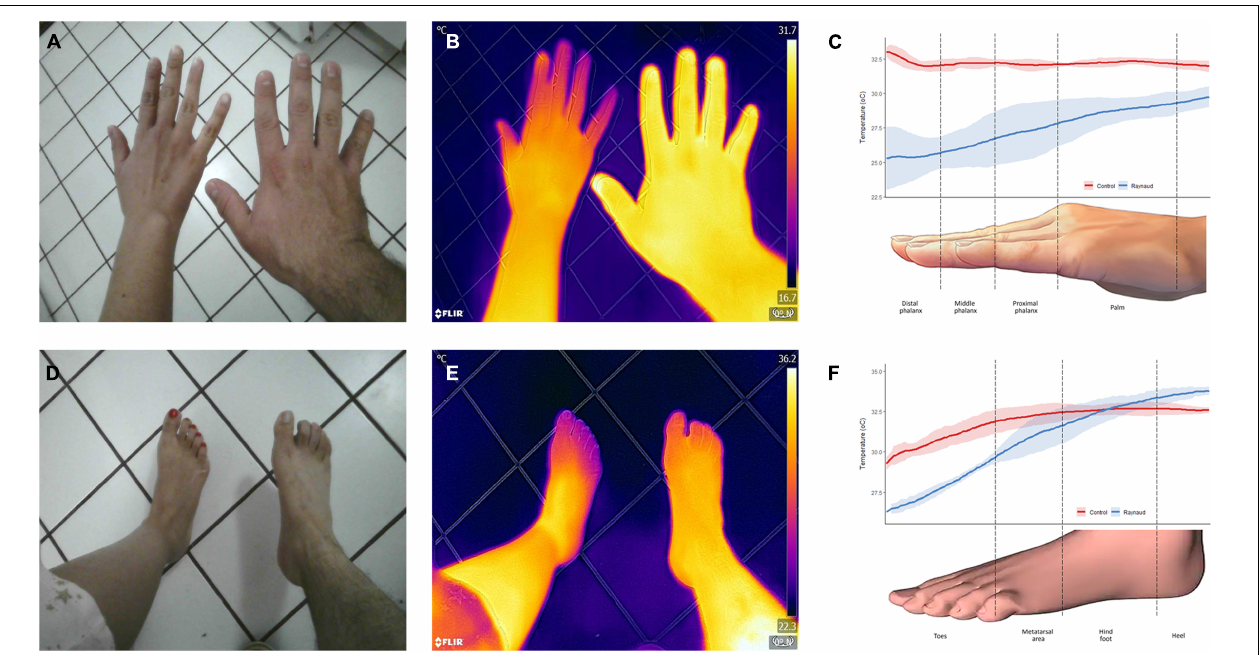
FIGURE 4 | Thermographic assessment of a patient with Raynaud’s phenomenon. Clinical photographs (A,D) and infrared thermal images (B,E) of the hand and feet of a patient with Raynaud’s phenomenon (left) and a healthy subject (right) were obtained. Color gradients of the heat maps are shown in the far-right side of (B,E) . Purple/blue indicates a lower temperature, while yellow/white indicates higher temperatures. Analysis of the temperature distribution across the different structures are presented in (C,F) . The patient’s temperature was significantly lower to the control and exhibited a higher degree of variation, as demonstrated by wider confidence intervals. The solid line represents the mean temperature, and the shaded area, its 95% CI. Images, courtesy of JR-G, were acquired using the Skin and Wound mobile app (Swift Medical Inc., Toronto, ON, Canada) paired to a FLIR One Pro camera. Analysis of the images was performed in Swift’s dashboard.